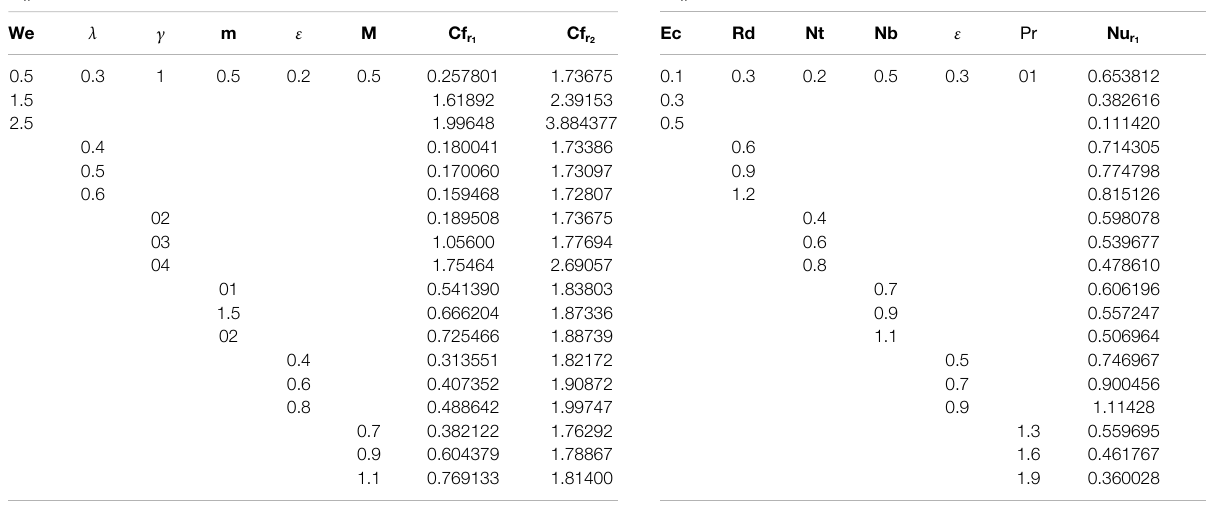
TABLE3| Effectsofparameters Ec , Rd , Nt , Nb , ε ,andPronlocalNusseltnumber